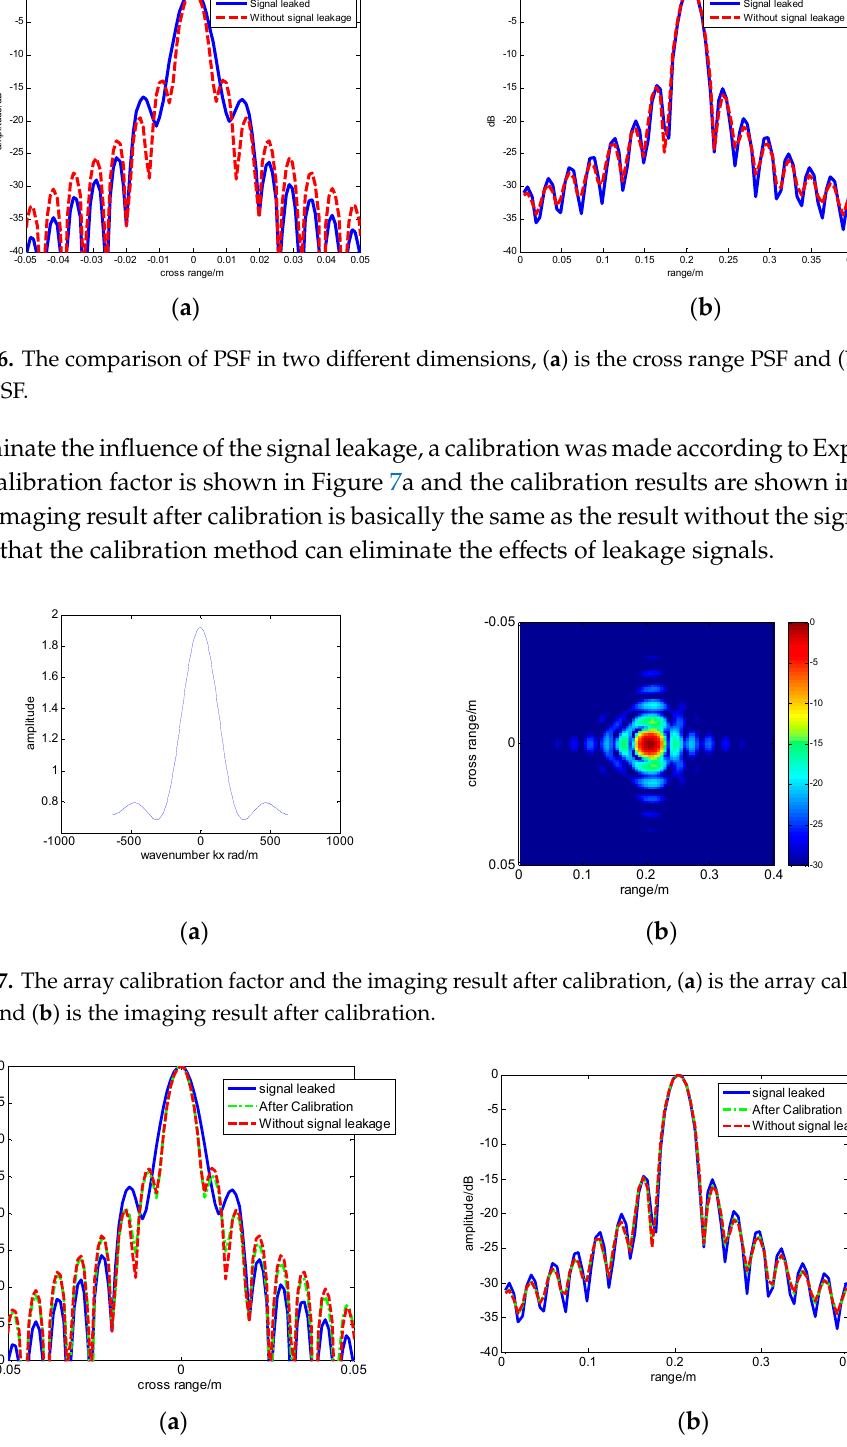
Figure 8. The PSF comparison of three different cases, ( a ) is the cross range PSF and ( b ) is the range PSF.